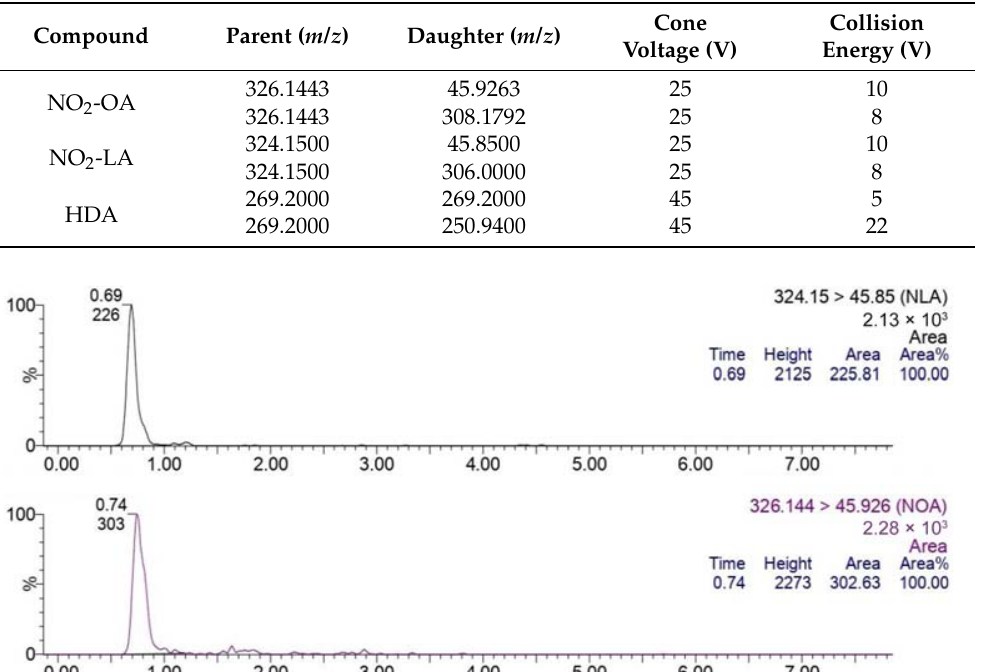
Table 1. Monitored transitions for NO 2 -OA, NO 2 -LA and HDA and their MS ionization parameters in negative ion MRM mode.